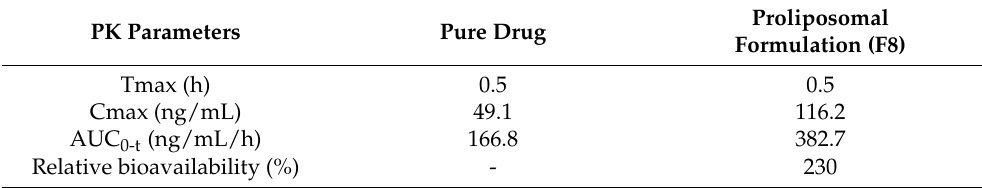
Figure 7. Mean plasma concentrations of AKH following oral administration of pure drug and its proliposomal formulation (F8). ####—Pure drug vs. F8 (Proliposome) with significance p < 0.0001; Table 10. Selected pharmacokinetic parameters of AKH pure drug and proliposomal